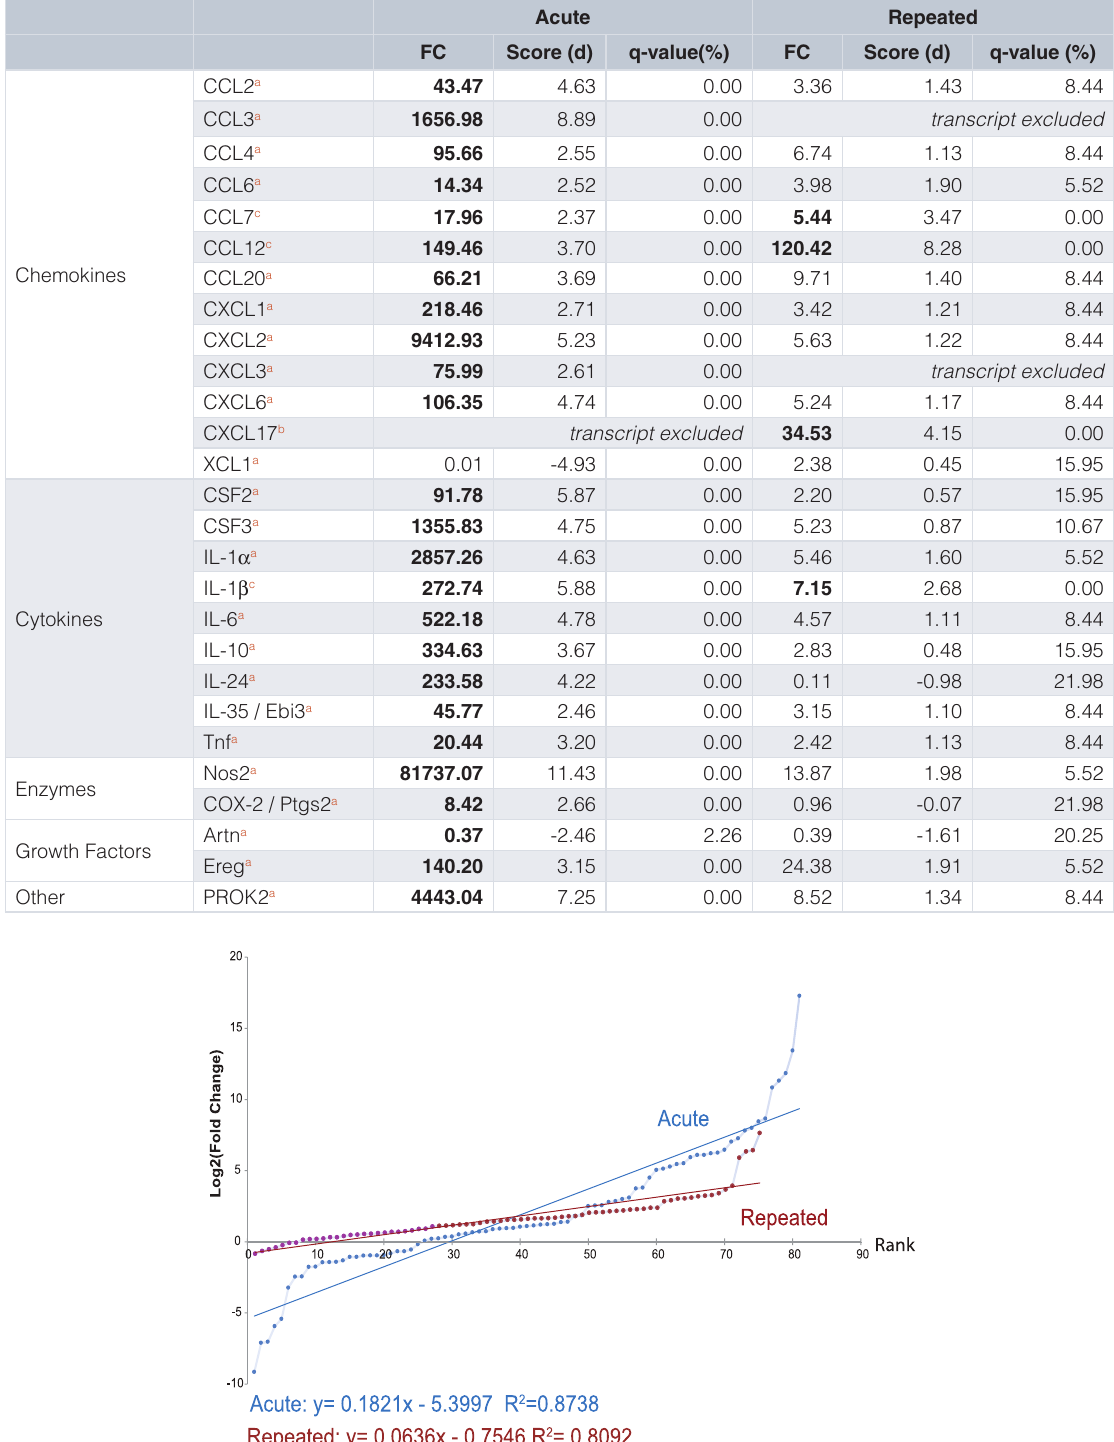
Figure 2. Ranked mean fold change of inflammatory cytokine mRNA transcripts 24 hours after acute (n=4) and repeated bladder inflammation (n=3), as compared to naive data, showing the increased up-regulation present following acute inflammation as compared with repeated inflammation. Following significance of microarray analysis, only inflammatory mediators showing up-regulation were significant